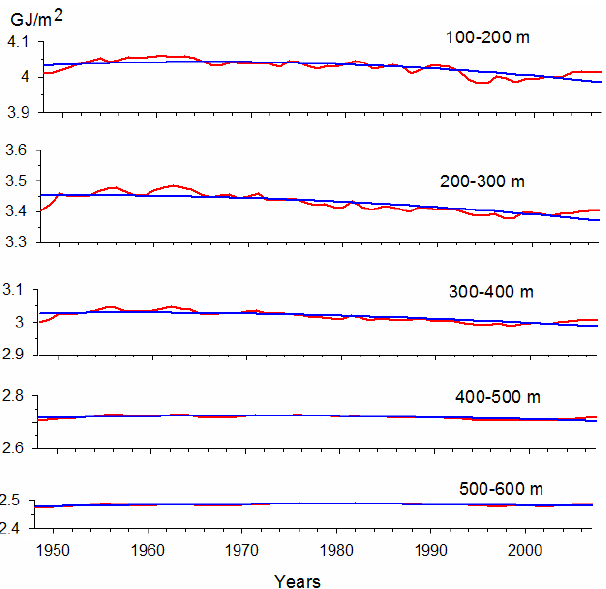
Figure 3. Time series of the WO heat content and its quadratic trend for the period 1948–2007 in the active upper layer (the main thermocline): 100–200 m, 200–300 m, 300–400 m, 400–500 m, 500–600